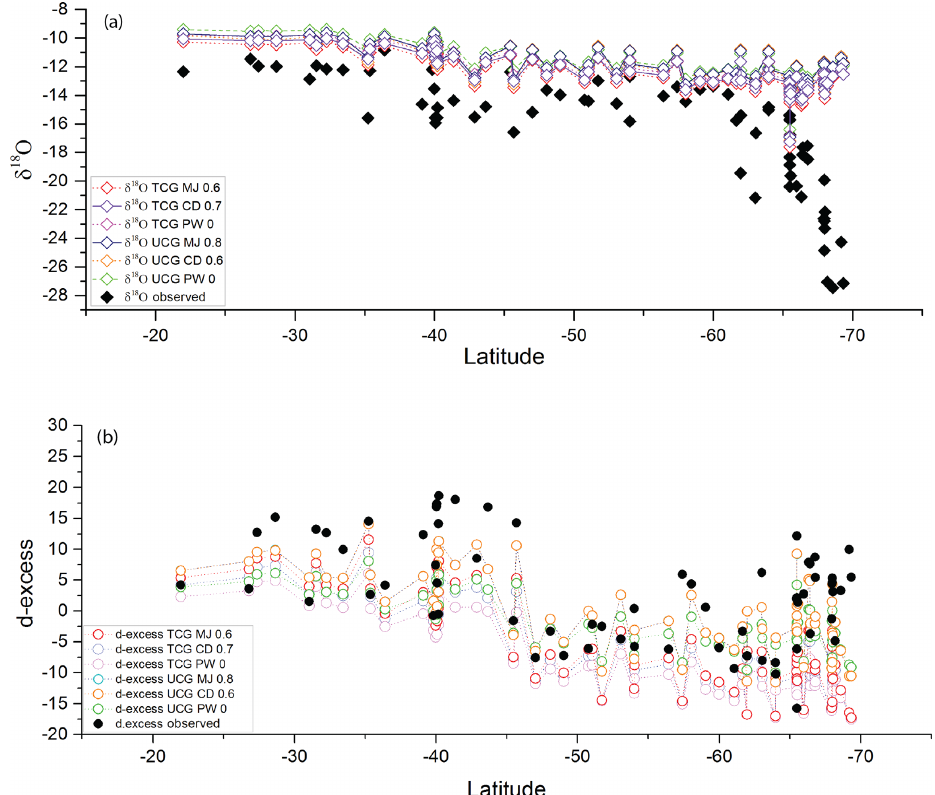
Figure 9. Latitudinal variation in the observed (a) δ 18 O as filled black diamonds and (b) d-excess as filled black circles and the modeled values (colored open diamonds and circles) for the model runs where the observed slope is comparable to the modeled slope. The statistical parameters analysis of the observed and modeled regression are listed in Table